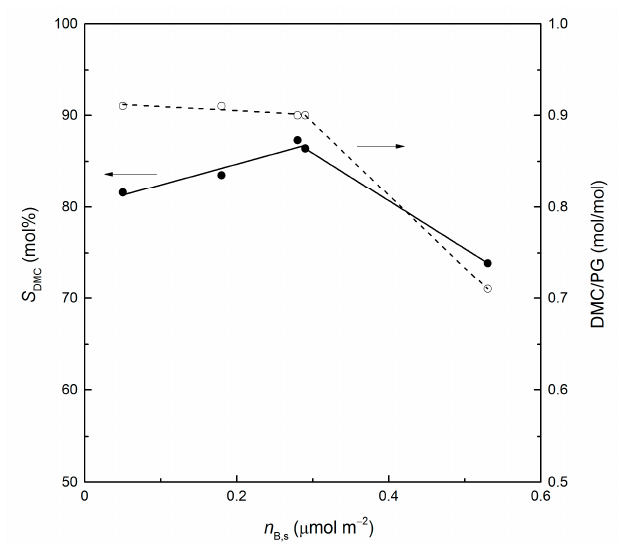
Figure 7. DMC selectivity ( ● ) and DMC/PG molar ratio ( ○ ) as a function of the strong basic sites’ concentration. Experimental conditions: T = 160 °C; autogenic pressure (15 bar); CH 3 OH/PC = 10 mol/mol; catalyst/PC = 0.03 g/g; reaction time = 4 h.